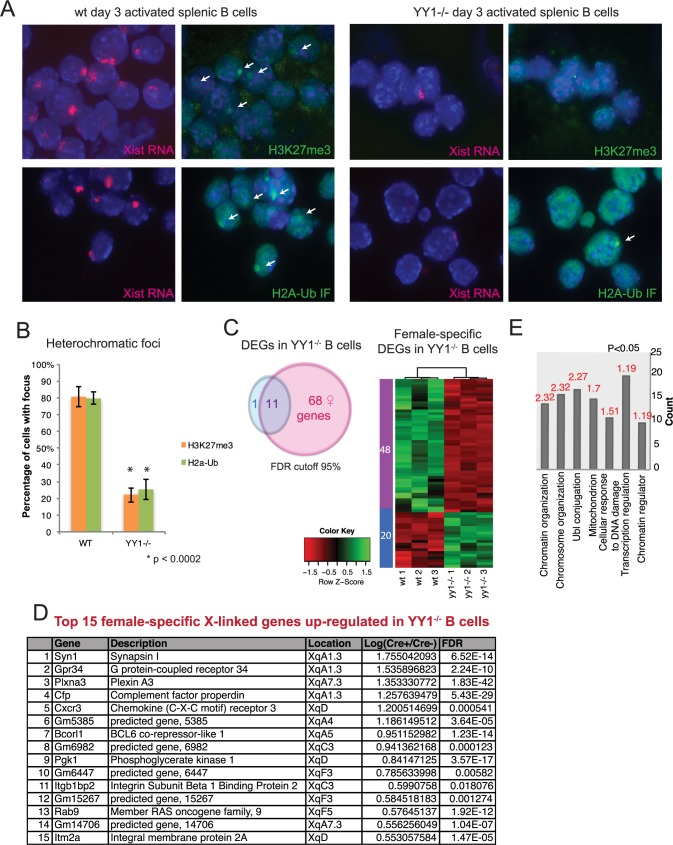
YY1 is required for Xi heterochromatin and X-linked gene dosage compensation in activated splenic B cells.(A) Sequential Xist RNA FISH (red) then immunofluorescence detection for H3K27me3 or H2a-Ub (green) in wild type (left) and ex vivo YY1 deleted (-/-; right) splenic B cells stimulated with CpG for 72 hrs. White arrows denote heterochromatic foci that overlap with an Xist RNA cloud. Representative results from one experiment are shown (n = 3). (B) Quantification of the number of nuclei in (A) containing a focus of heterochromatin. The averages from 3 experiments are shown, and statistical significance was determined using two-tailed t-test. Error bars denote standard deviations from the mean for biological replicates between independent experiments. (C) Sex-specific differentially expressed genes (DEGs) in YY1-/- B cells. Venn diagram shows the comparison of RNA-seq results for unique male (blue) versus unique female (pink) YY1-/- activated B cells. Shared DEGs shown in purple. Heat map shows hierarchical clustering of expression for the 68 female-specific X-linked transcripts for female wildtype and female YY1-/- activated B cells. Cells were harvested two days after Cre-mediated deletion, corresponding to 48 hrs of stimulation. See S1 and S2 Tables for complete gene lists. Three independent mice for each condition (wildtype and YY1-/-) and sex were used for RNA isolation. (D) List of top 15 female-specific up-regulated X-linked genes in YY1-/- B cells. Complete lists are shown in S1 Table. (E) Gene Ontology analysis for the complete list of X-linked genes upregulated in YY1-/- B cells compared to female wildtype cells. Enrichment Score (ES) > 1, p < 0.05. The complete gene lists are shown in S2 Table.